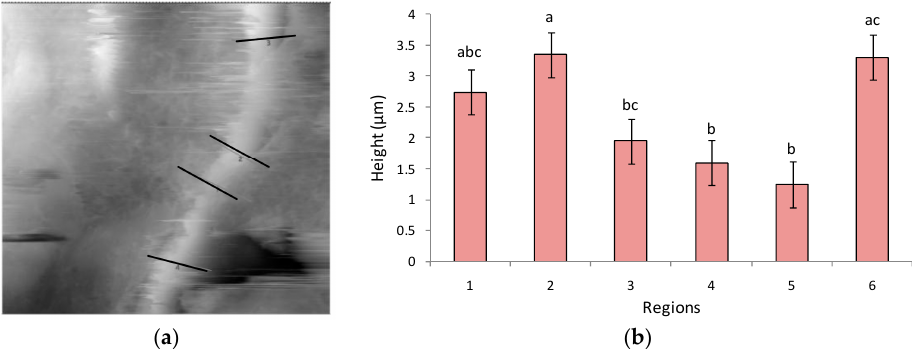
Figure 5. ( a ) Area of 50 µm 2 of the rostral field of a scale of region 4 obtained by AFM. In one of the circuli, height has been measured through its extension (black lines) and the mean has been considered the mean height for circuli from region 4; ( b ) Graph showing the differences in the height of circuli. Significant differences occur when two regions do not share any letter ( p < 0.05).